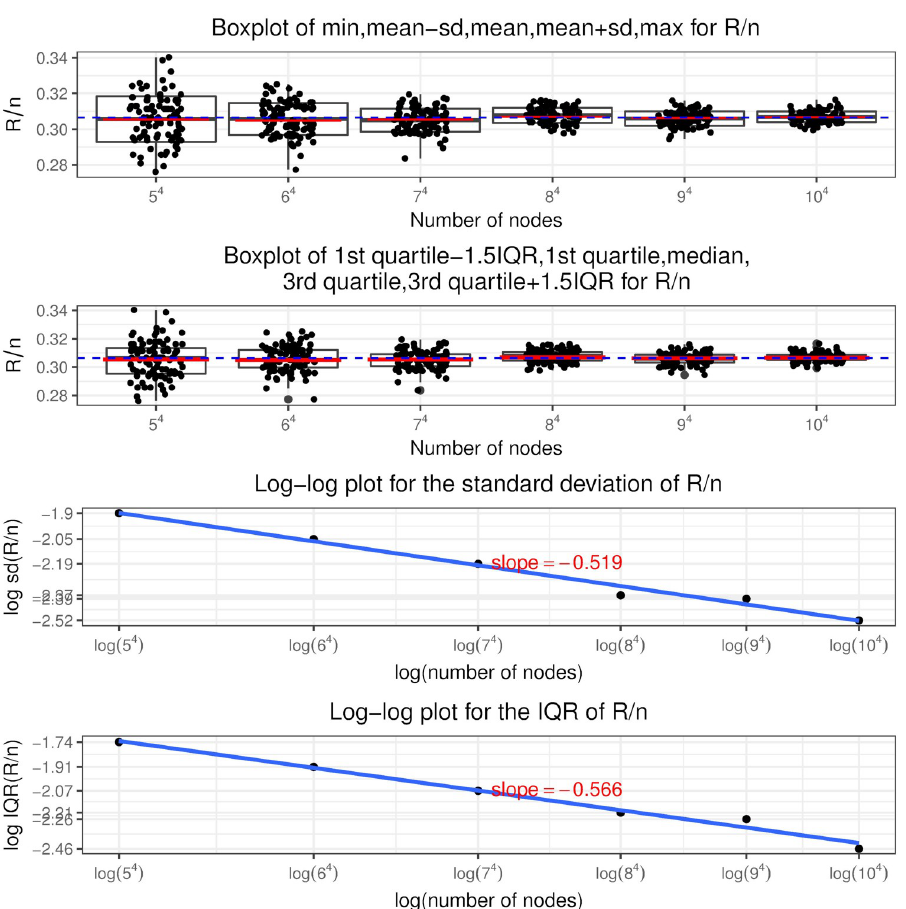
Fig 6. The boxplot and log-log plot of standard deviation and IQR for R / n under optimal policy.